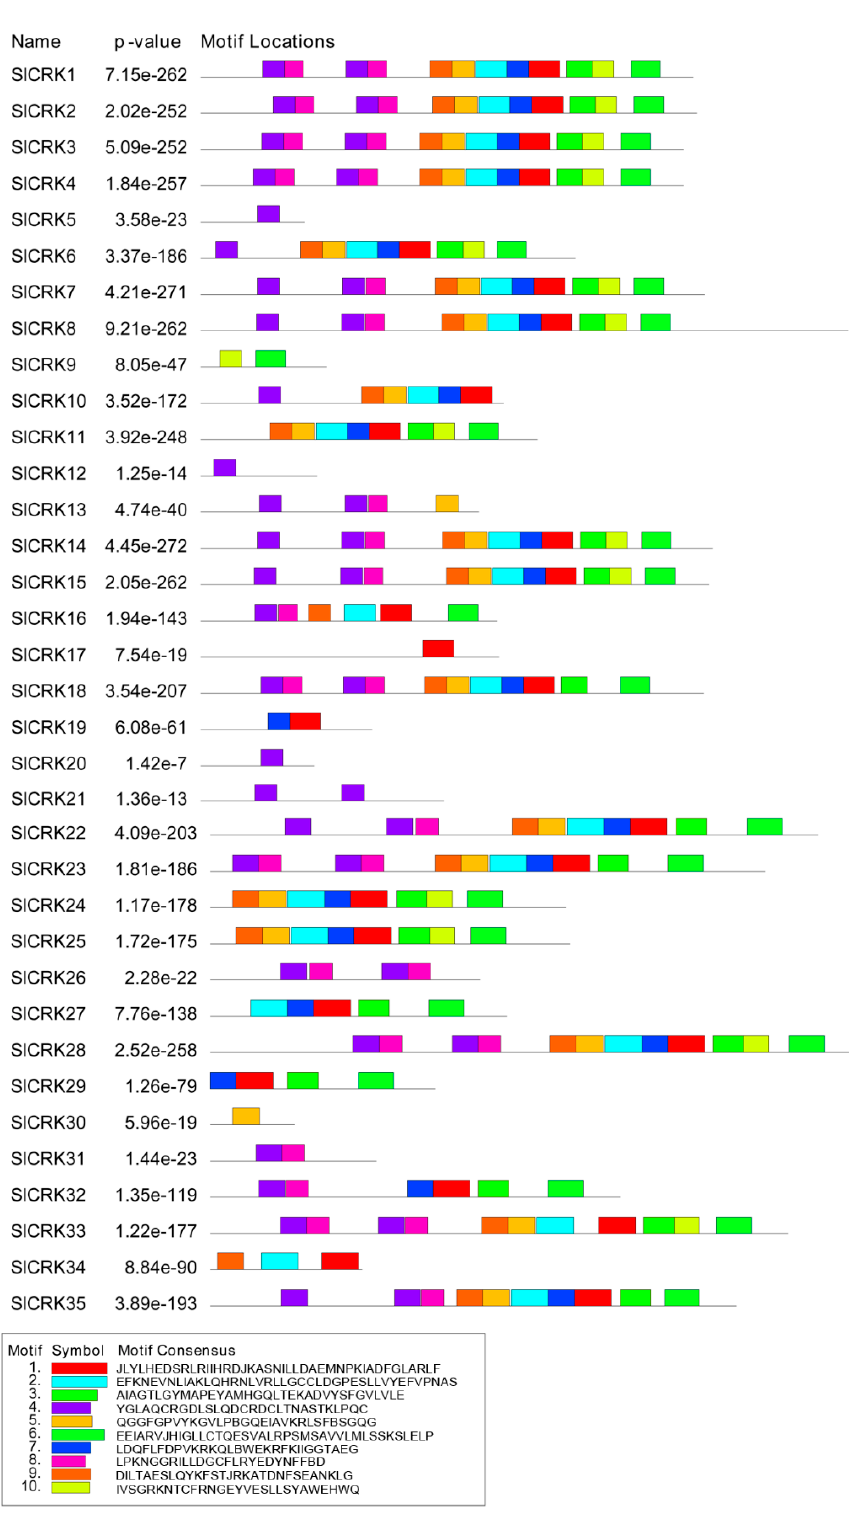
Figure 5. Identification of conserved motifs in SlCRK protein sequences. Significantly overrepre- sented motifs are graphically depicted by bars corresponding to their predicted positions. The red boxes (Motif 1) represent kinase domains (PF00069). The sapphire and grass green boxes (Motif 2 and 3) represent protein tyrosine kinase domain (PF07714) and the purple boxes (Motif 4) represent salt stress response/anti-fungal domain (PF01657). The remaining 6 motifs showed no match in the Pfam IDs.